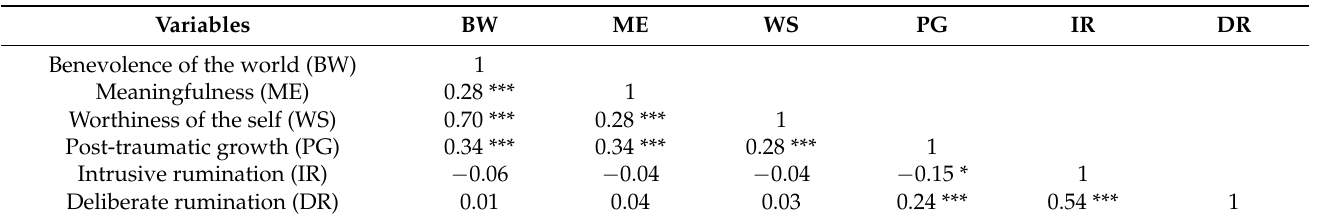
Table 3. Pearson correlation coefficients between world assumptions, post-traumatic growth, and rumination ( N =